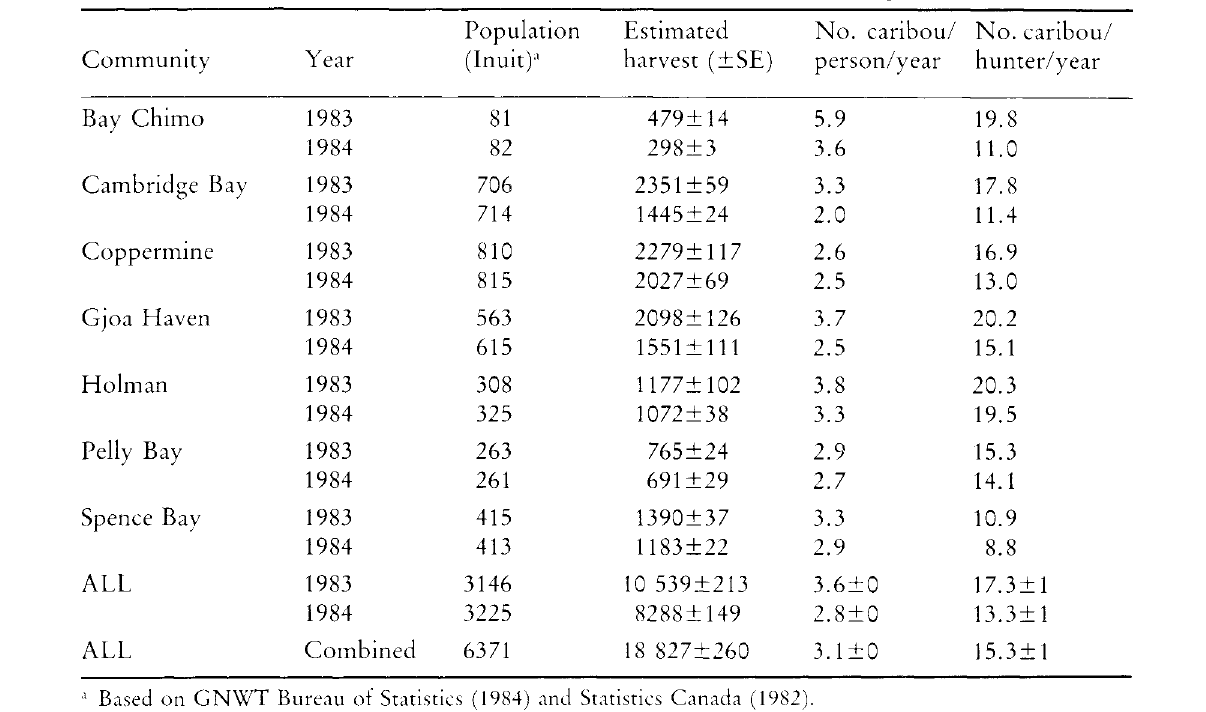
Table 2. Per capita harvesting levels (means ± SE) of caribou in the Kitikmeot Region, N W T.